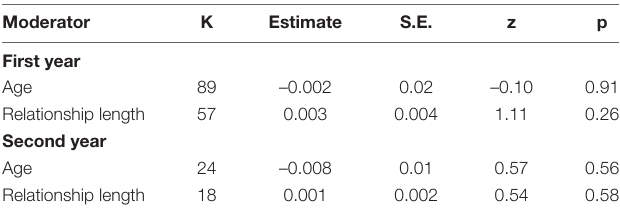
TABLE 3 | Meta-regression to test for moderation in the decrease in marital satisfaction (continuous